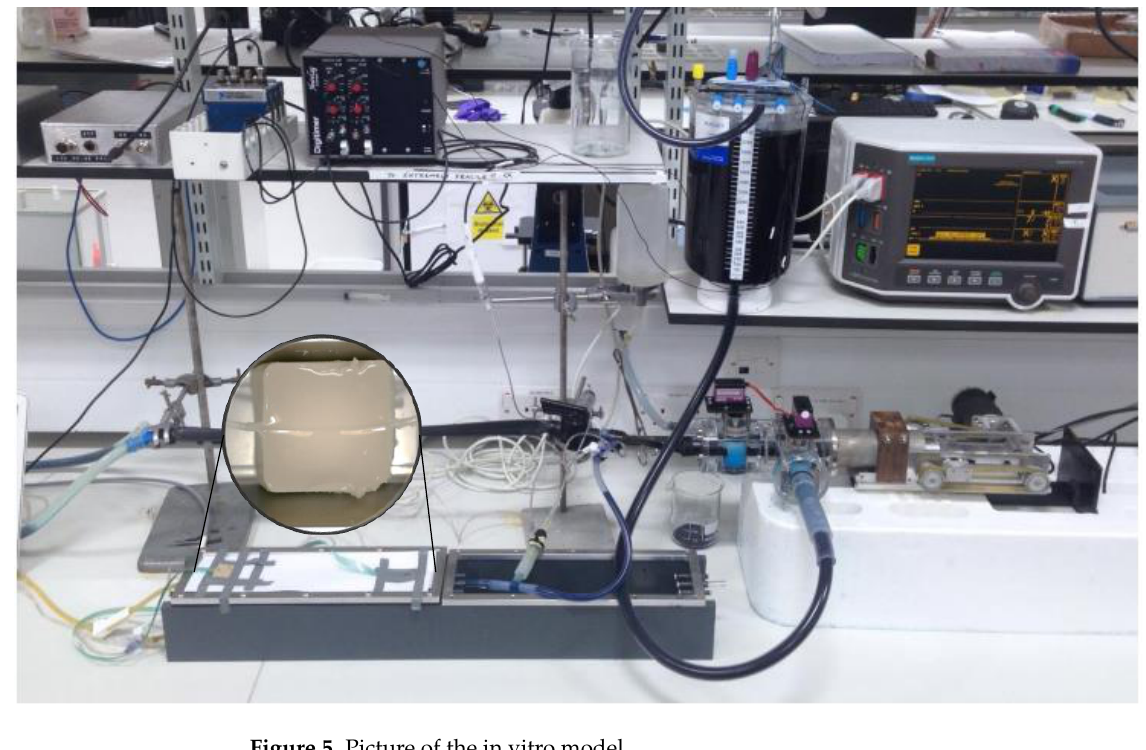
Figure 5. Picture of the in vitro model.